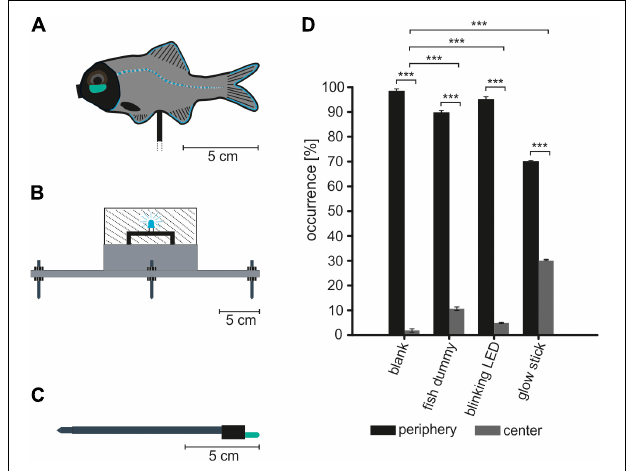
FIGURE 2 | Fish and light organ dummies. Relative occurrence of P. steinitzi in the center and periphery of small territories in reef caves where P. steinitzi reside after sunset. (A–C) The following dummies were used in the experiments. (A) A fish dummy with integrated artificial light organs. Artificial light organs consisted of an acrylic glass pipe with a glow stick and acrylic glass covered the artificial light organs in the fish dummy. (B) Blinking light organ dummy. The dummy consisted of a PVC base and an acrylic glass cylinder. A 5 mm LED produced a 1 Hz blinking signal with 500 nm peak wavelength. (C) Constantly glowing light organ dummy. The dummy was made of an aluminum stick (130 mm length) and a glow stick (4.5 mm Ø, 37 mm length) mounted on the tip. The glow stick surface was reduced to 10 mm to simulate the light organ size in P. steinitzi . (D) Relative occurrence time (in percent of 5 min recording intervals) of P. steinitzi after sunset in the entrance area of reef caves. Comparison of relative times between center and periphery and time in center between the different recording conditions (blank, dummy, blinking LED, and glow stick). Black bars indicate occurrence time in the territory periphery. Gray bars indicate occurrence time in the center of the territory. Error bars indicate mean ± SEM. Significance values are reported as: * p ≤ 0.05; ** p ≤ 0.01; *** p ≤